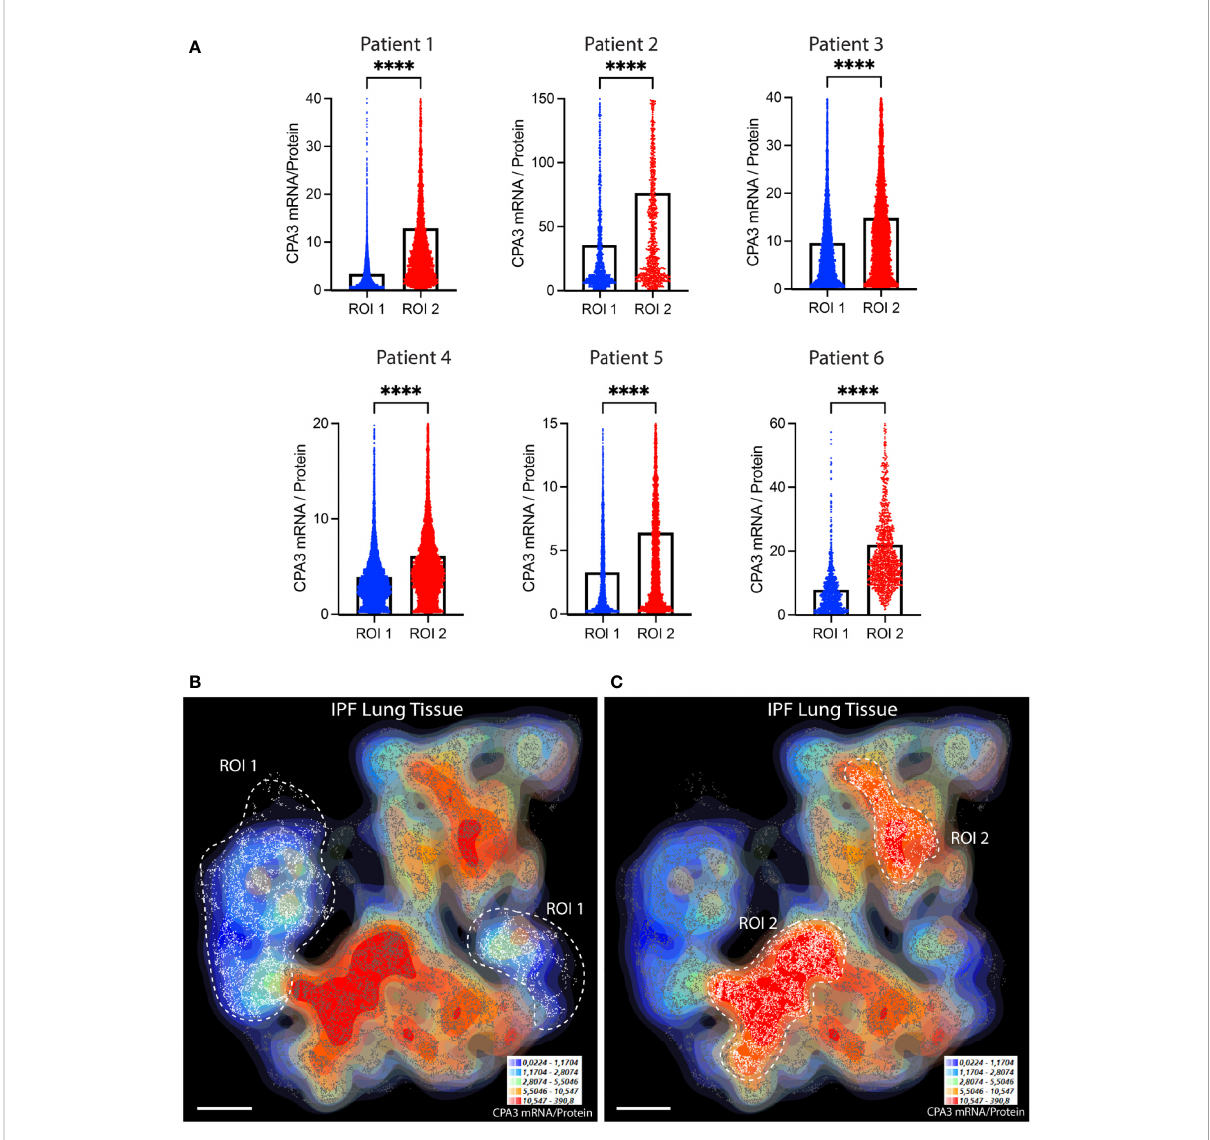
FIGURE 4 The relative proportion of mast cell CPA3 mRNA and stored protein vary signi fi cantly between lung tissue microenvironments. (A) Quantitative data and violin plots comparing individual mast cell CPA3 mRNA/protein quotients in pre-determined spatial lung section regions of interest (ROIs). Regions with relatively low (ROI type 1) or high (ROIs 2) quotients were selected from computer-generated topographic contour maps visualizing the heterogeneous spatial distribution of mRNA/protein quotients (exempli fi ed for one IPF section in (B) and (C) ; red denotes spatial regions with a high quotient; coordinates for individual mast cells are shown as white-gray dots). Scale bars: B , C = 3.5 mm. Black bars in A show mean values and statistical analysis was performed by a Mann – Whitney U test and where **** denotes a signi fi cance level of p <